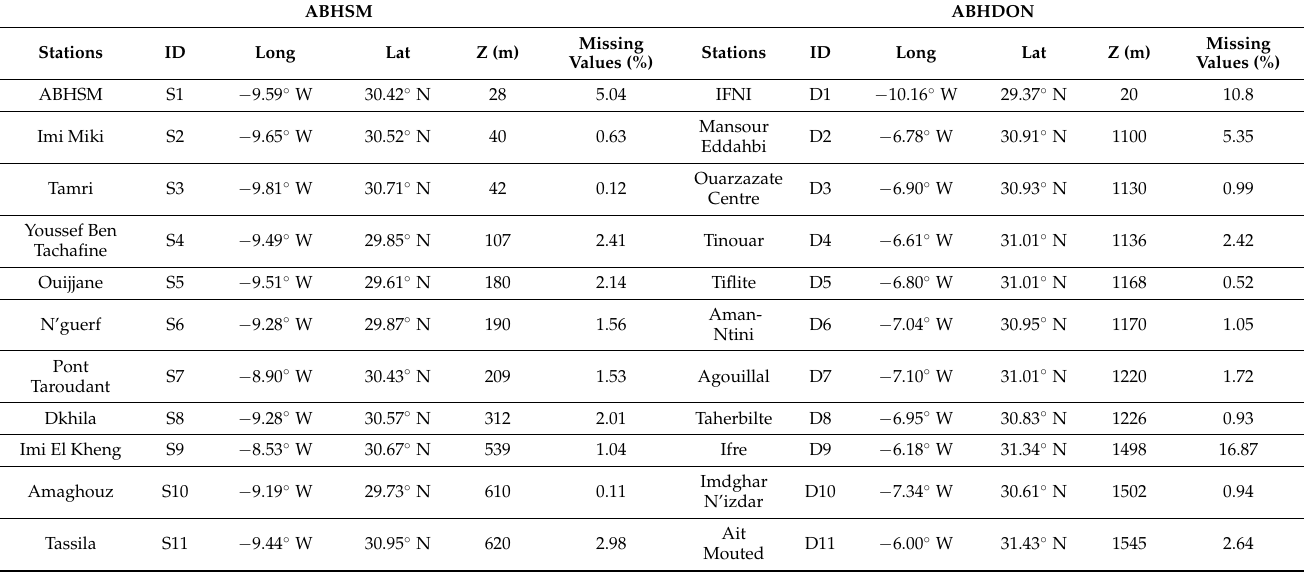
Table 1. Coordinates of the stations used in this study and their missing values rate. ID: Identification of rain gauge, where S for Souss and D for Draa, Lat is Latitude, Long is longitude, and Z is altitude. ABHSM ABHDON